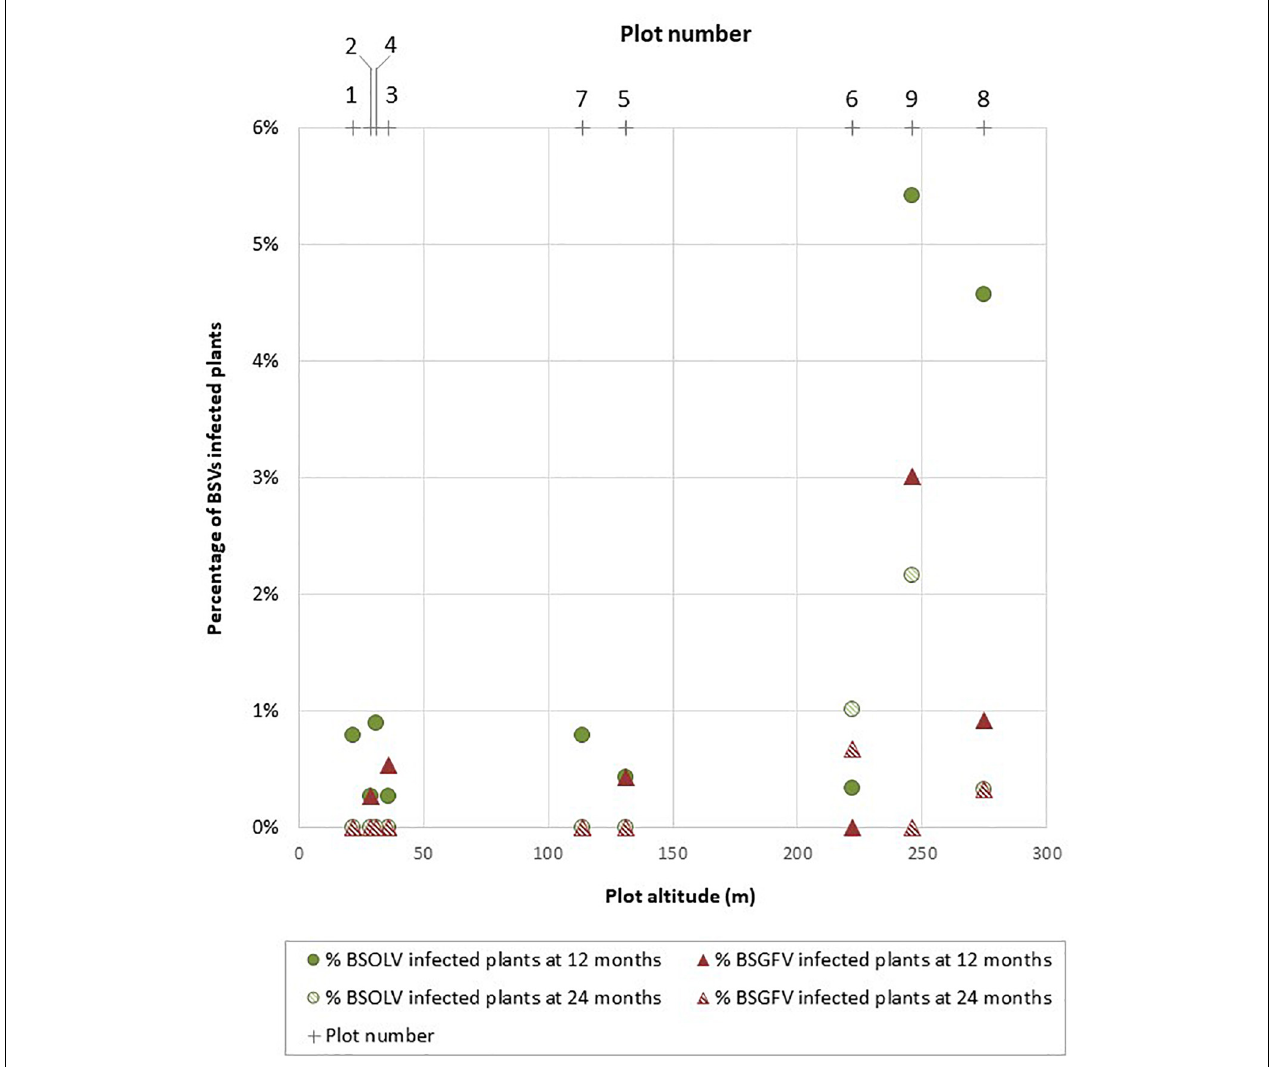
FIGURE 3 | Activation patterns of eBSOLV and eBSGFV infectious alleles in cultivar French Clair during a multi-site trial. Plot numbers and plot altitudes are